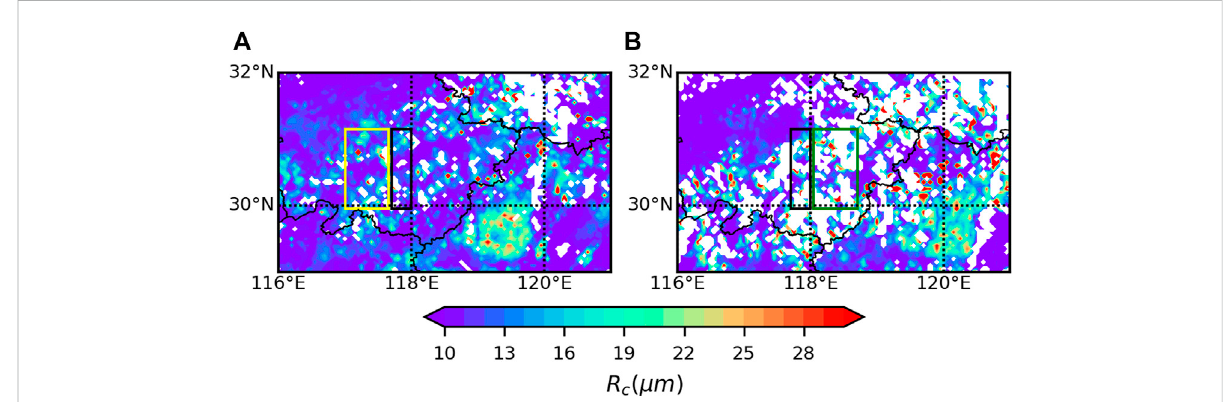
FIGURE 11 Clouddropleteffectiveradius( R c )beforeandafter seedingdetectedbyHimawari-8satelliteat (A) 15:00LTand (B) 16:00LT.Theblackboxrefer s to seeding area, the yellow box is upstream area without seeding in fl uence, and the green box is downstream area in fl uenced by seeding.